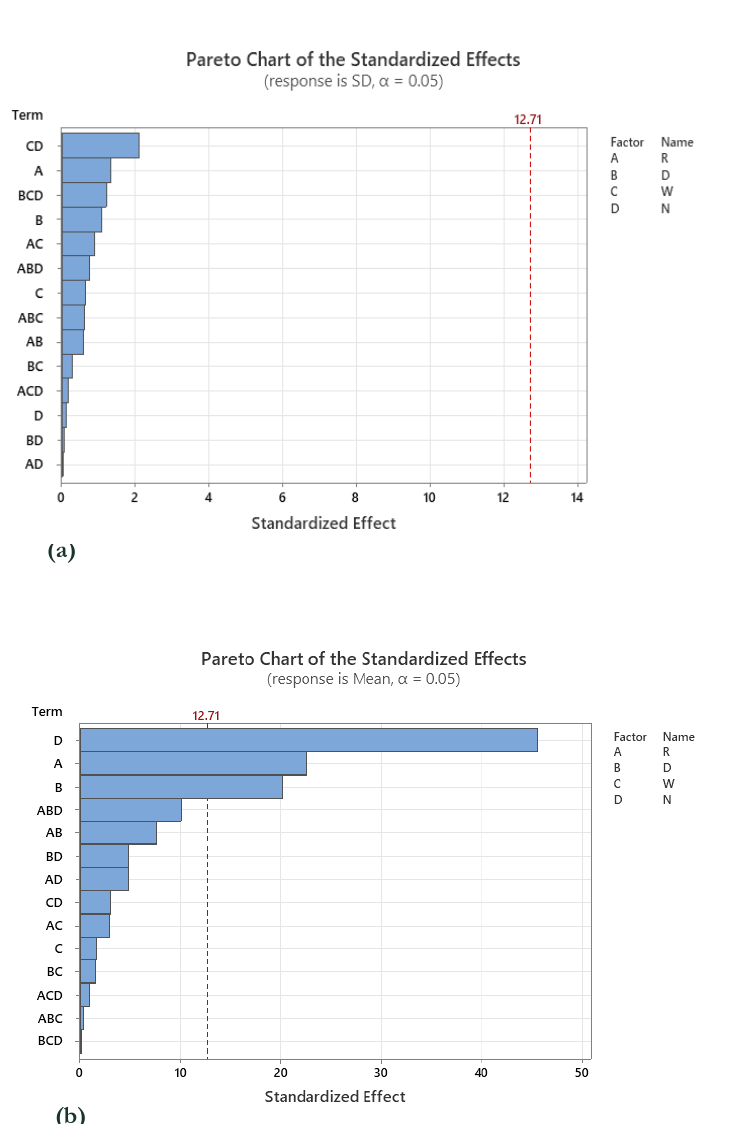
Fig. 3. Pareto chart for standard effect on SD and mean of reshaping time respectively.